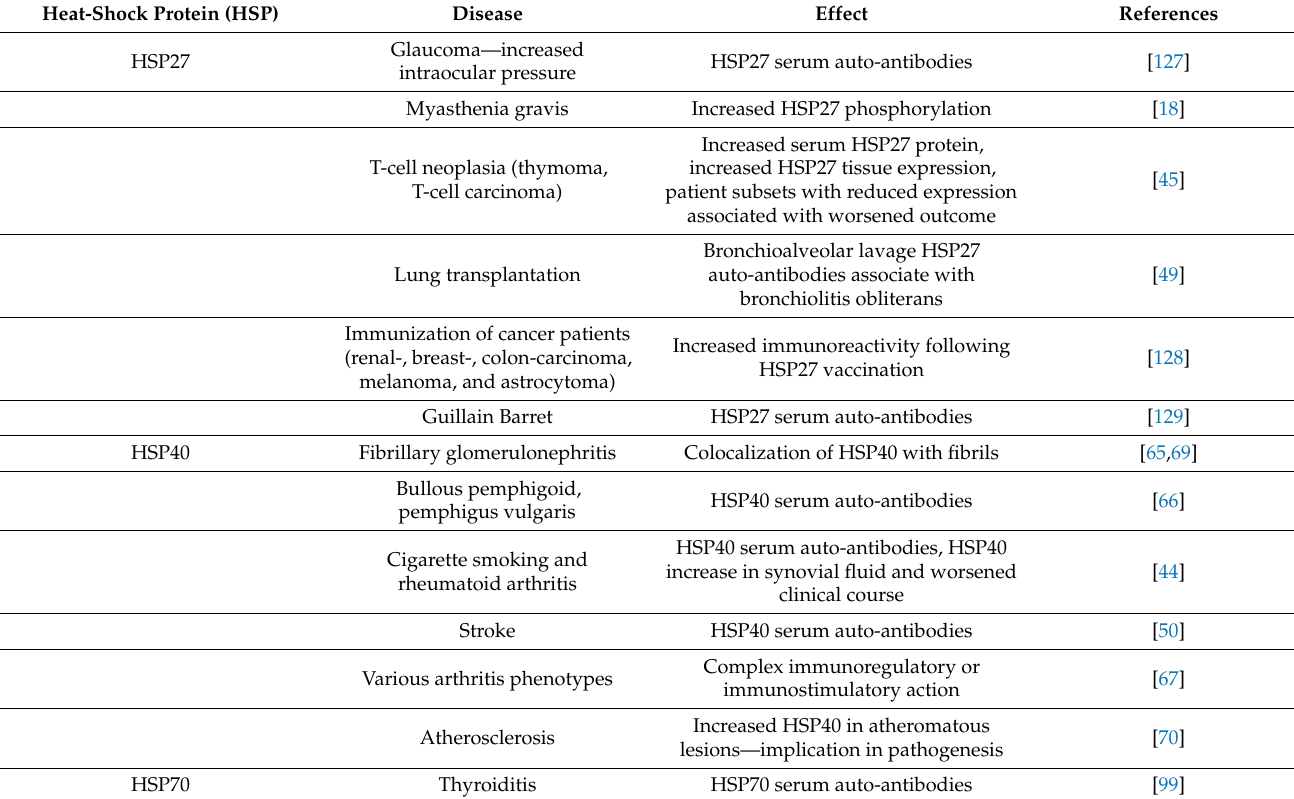
Table 1. Heat-shock proteins (HSP) in human autoimmune